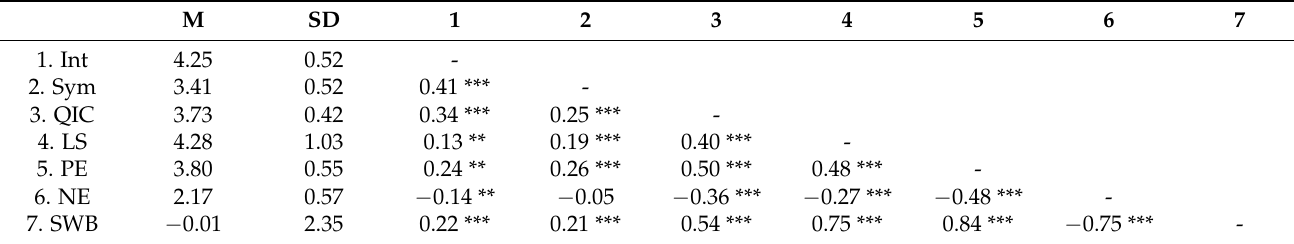
Table 1. Descriptive statistics and correlations between study